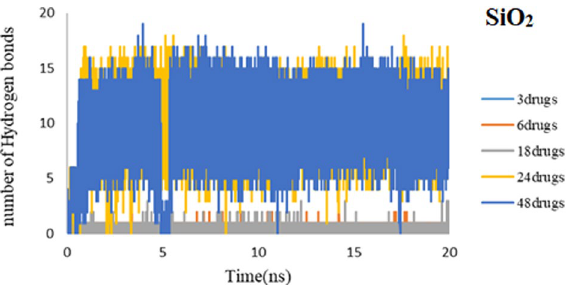
Figure 21. Number of hydrogen bonds between 3TC molecule and SiO 2 during simulation